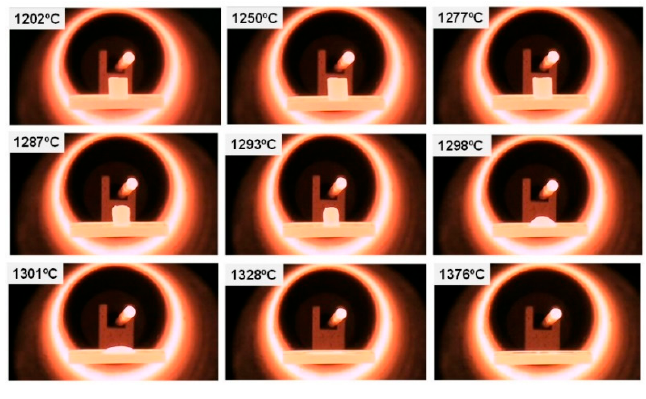
Figure 7. Heating microscopy.